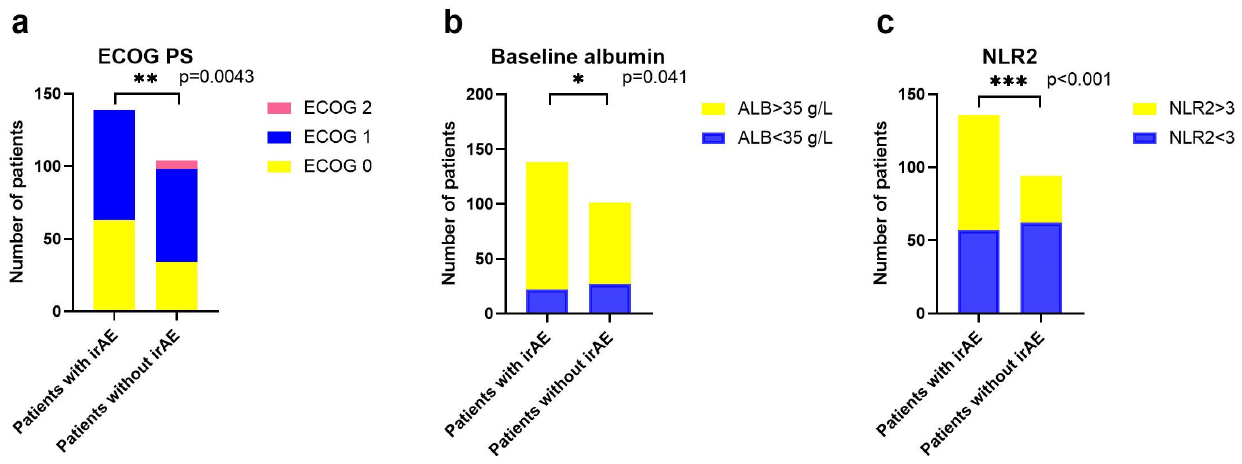
Figure 2. The development of irAEs corresponds to ECOG PS ( a ), baseline albumin ( b ), and NLR2 ( c ). Chi-square tests or Fisher exact tests were used to make intergroup comparisons. * p < 0.05, ** p < 0.01, *** p < 0.001 and not significant (ns).